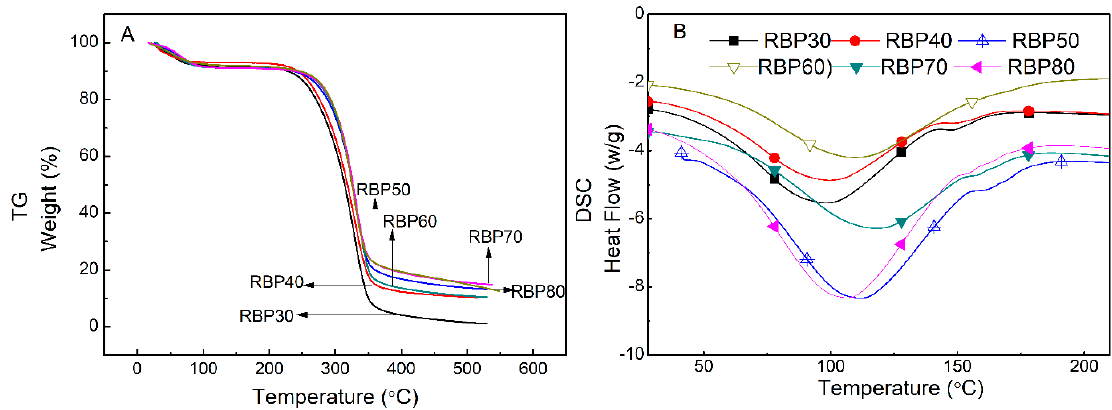
Figure 5. Thermal properties of RBPs.